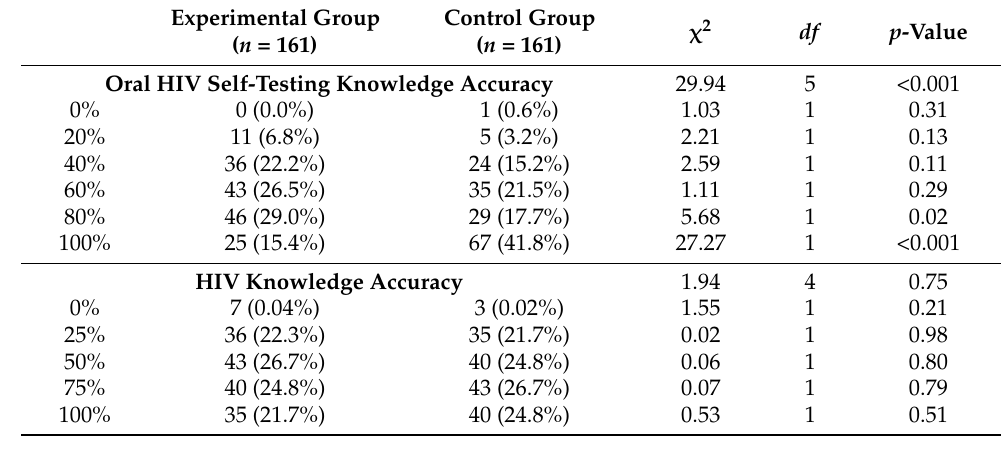
Table 3. Chi-square test on oral HIV self-testing knowledge and HIV knowledge accuracy between experimental group and control group.